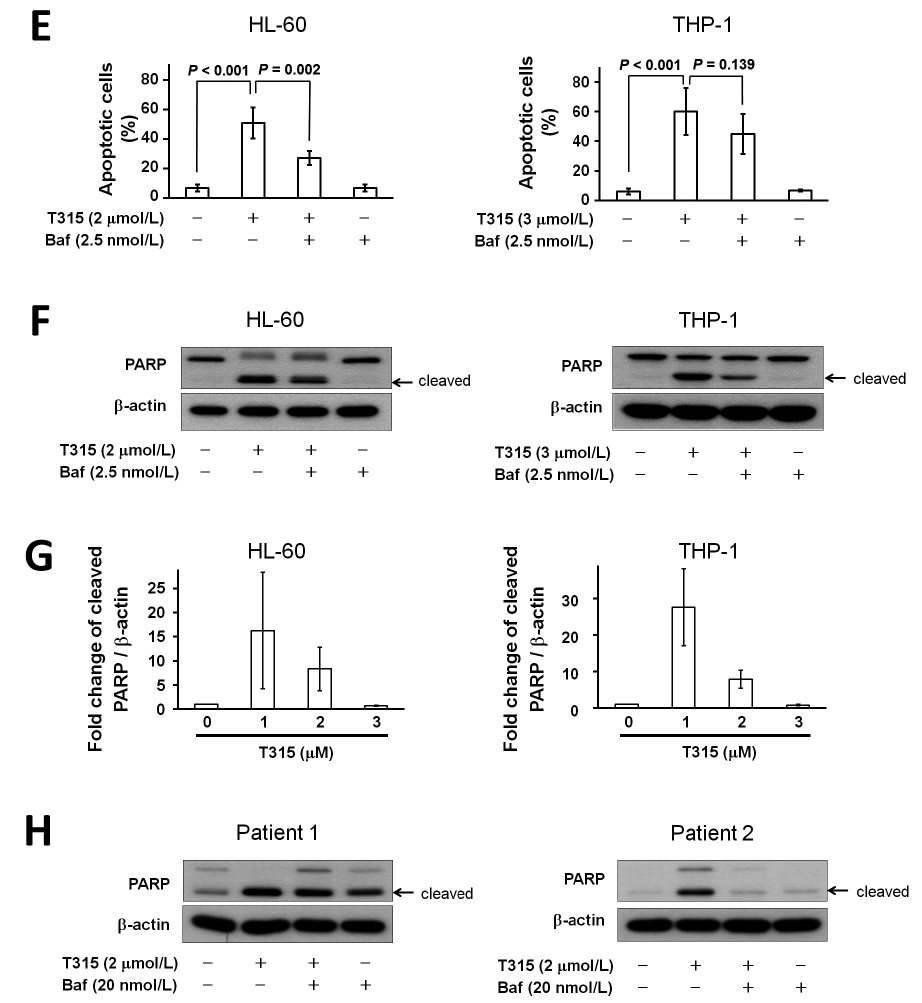
Figure 4. T315 induces autophagic cell death but not protective autophagy in AML cells. ( A ) T315 induced upregulation of LC3B-II in HL-60 and THP-1 cells. Cells (0.25 × 10 6 cells/mL) were treated with indicated concentrations of T315 for 24 h. 20 µg protein from cell lysates were used for Western blot analysis; ( B ) Histogram of fold change of LC3B-II/GAPDH protein expression in cells treated with T315 for 24 h ( n = 3); ( C ) T315-induced apoptosis was partially rescued by chloroquine (CQ), an autophagy inhibitor. Cells were treated with DMSO vehicle or T315 for 24 h with or without pretreatment of CQ for 1 h, and then analyzed by a flow cytometer. ( n = 3 for HL-60 and n = 4 for THP-1 cells); ( D ) T315-induced apoptosis was partially rescued by 3-methyladenosine (3-MA), an autophagy inhibitor. Cells were treated with DMSO vehicle or T315 for 24 h with or without pretreatment of 3-MA for 1 h, and then analyzed by a flow cytometer. ( n = 4 for HL-60 and n = 5 for THP-1 cells); ( E ) T315-induced apoptosis was partially rescued by bafilomycin-A1 (Baf), an autophagy inhibitor. Cells were treated with DMSO vehicle or T315 for 24 h with or without pretreatment of Baf for 1 h, and then analyzed by a flow cytometer. ( n = 5 for HL-60 and n = 5 for THP-1 cells); ( F ) T315-induced PARP cleavage was partially rescued by Baf. Cells were treated with DMSO vehicle or T315 for 24 h with or without pretreatment of Baf for 1 h, and then analyzed by Western blotting; ( G ) Histogram of fold change of cleaved PARP/ β -actin protein expression in cells treated with T315 with or without pretreatment of Baf for 1 h ( n = 3); ( H ) T315-induced PARP cleavage in primary AML cells was partially rescued by Baf. Primary AML cells were treated with DMSO vehicle or T315 for 24 h with or without pretreatment of Baf for 1 h, and then analyzed by Western blotting (two patients’ data shown here).